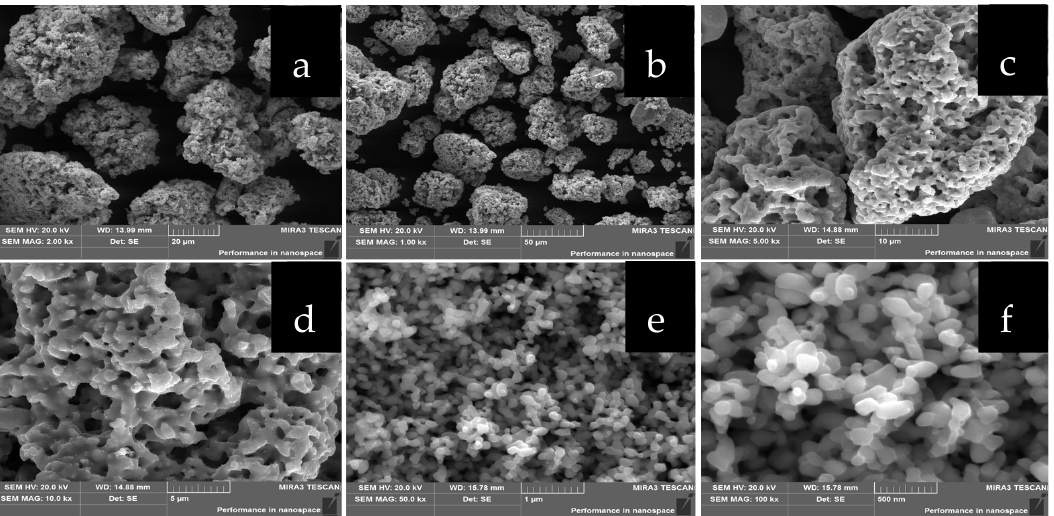
Figure 7. SEM images of cuprous sulfide with different morphologies: the scanning images of ( a , b ) Cu 2 S(I); the scanning images of ( c , d ) Cu 2 S(II); the scanning images of ( e , f ) Cu 2 S(III). Figure 7e,f are the scanning images of Cu 2 S(III) prepared by annealing at 600 ◦